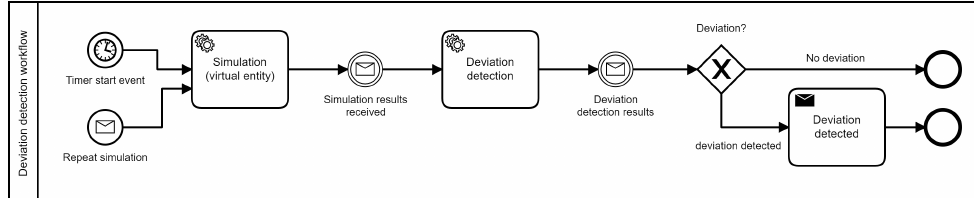
Figure 5. BPMN representation of an exemplary workflow for the application deviation detection. Services communicate via their corresponding MQTT request and response topics, as illustrated in Figure 3. The simulation service can query and fetch virtual entity models via information from the data dimension (see Figure